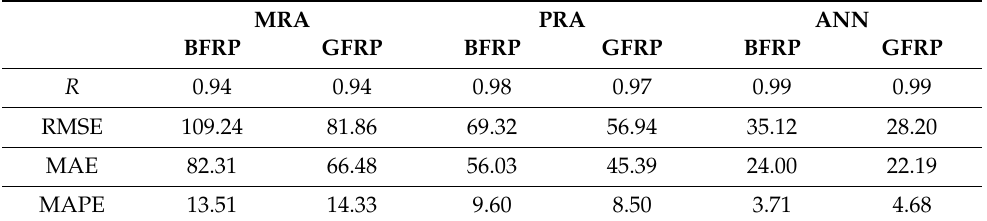
Table 6. Comparison of each model developed by MRA, PRA, and ANN